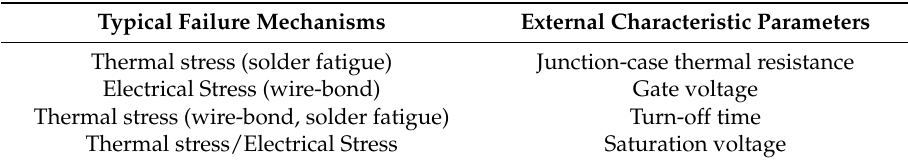
Table 1. Typical failure mechanisms and external characteristic parameters.